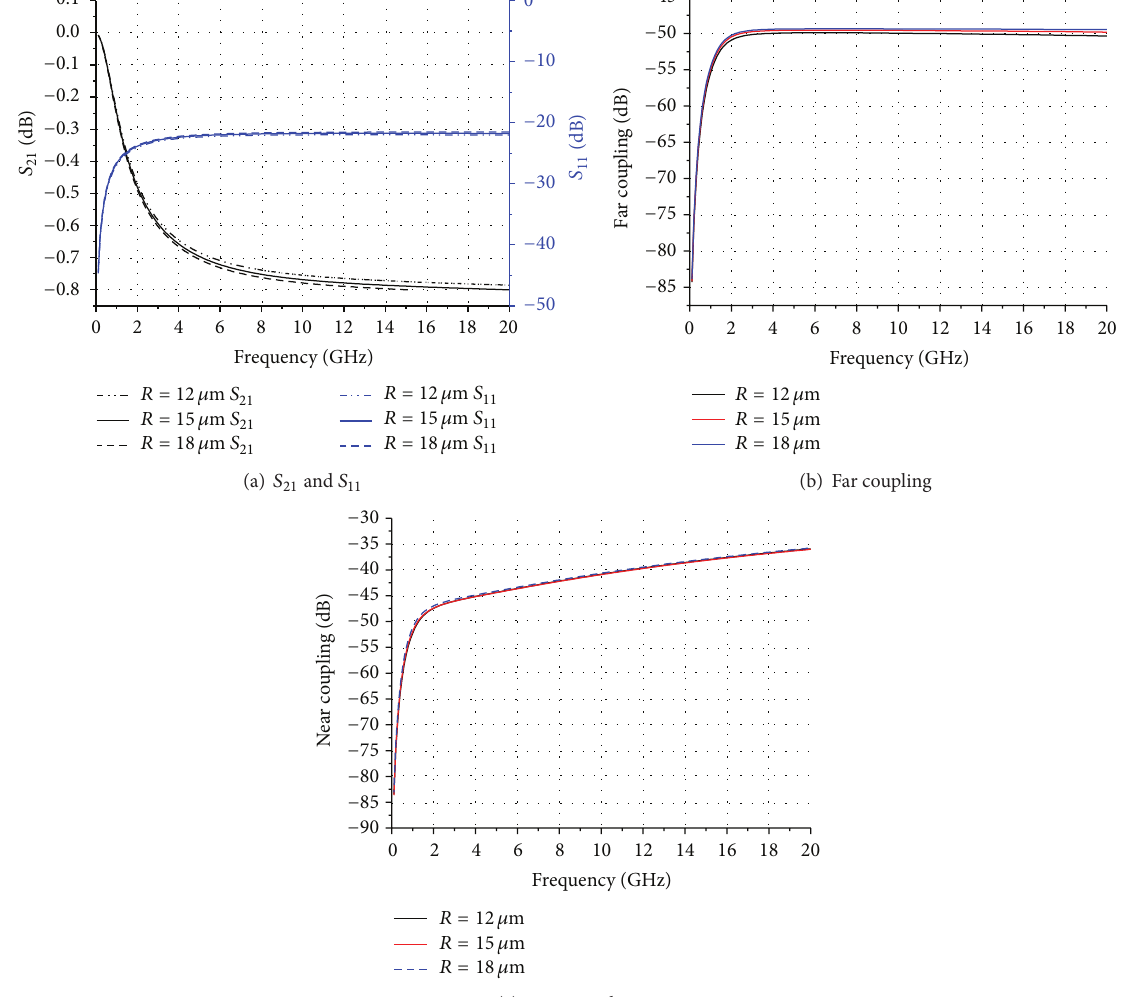
(c) Near coupling Figure 9: 𝑆 parameters of the TSV model with different bump